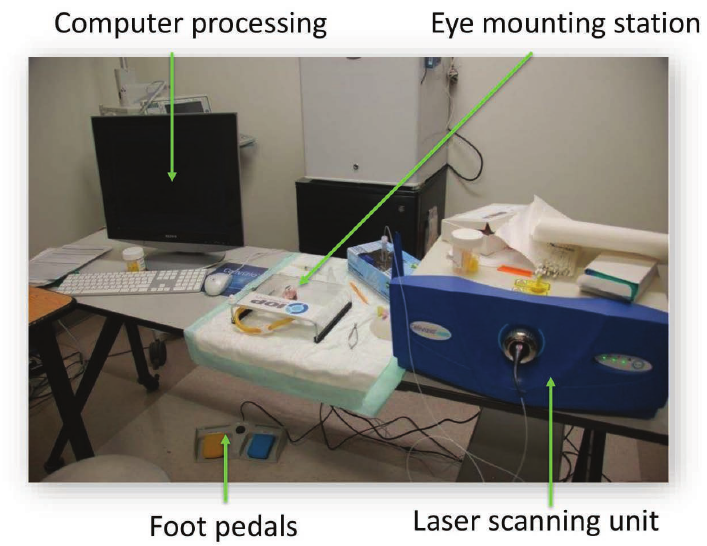
Figure 1. The fiber-optic confocal laser microendoscope imaging system. The laser scanning unit emits light at 488 nm, which is fed into the flexible fiber-optic core. The fluorescent emission is collected in the same fiber that was used for illumination. The microendoscope has a diameter of 1.5 mm and projects a field of view of 423 × 423 𝜇 m. Lateral and axial resolutions are 3.5 𝜇 m and 15 𝜇 m, respectively. The operator maneuvers the tip of the fiber-optic microendoscope to image different areas. Real-time image and video capture are activated via a foot